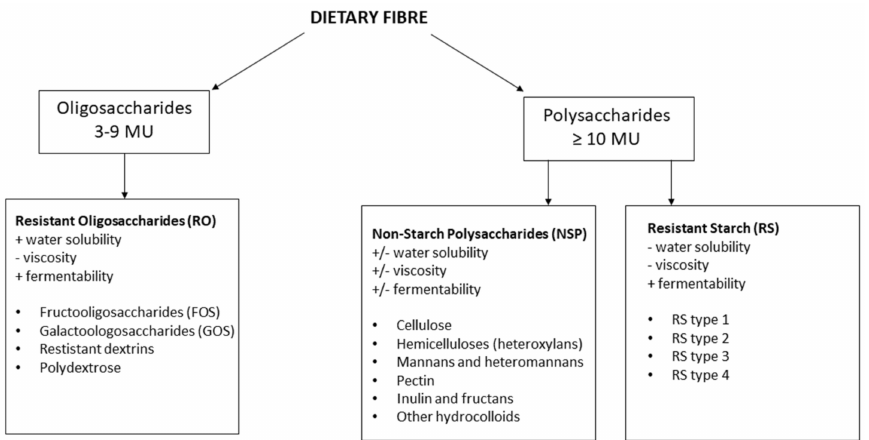
Figure 1. Classification of dietary fiber. NSP: Non-starch polysaccharides, MU: Monomeric units, RO: Resistant oligosaccharides, RS: Resistant